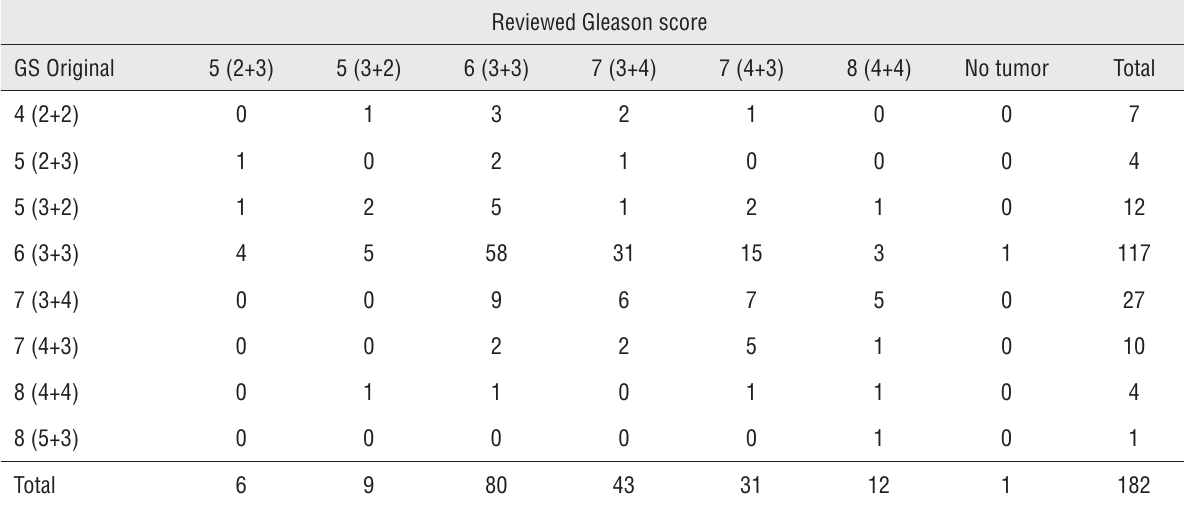
Table 1 - Frequency in distribution of Gleason scores on prostate biopsy.